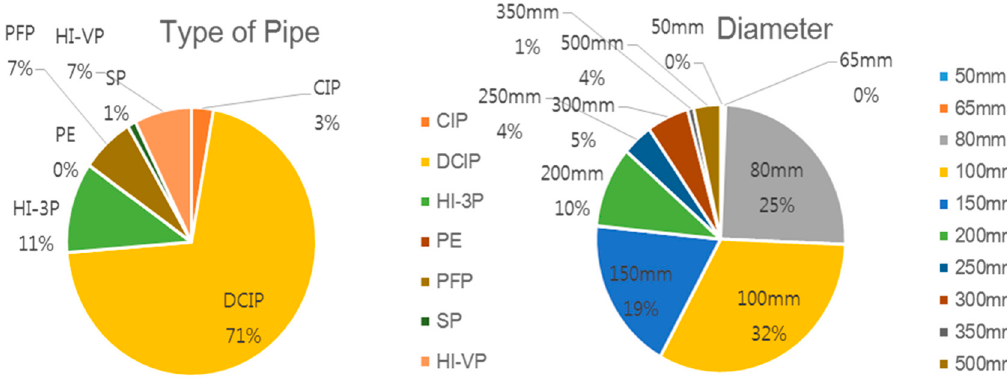
Figure 7. Characteristics of water distribution pipes.